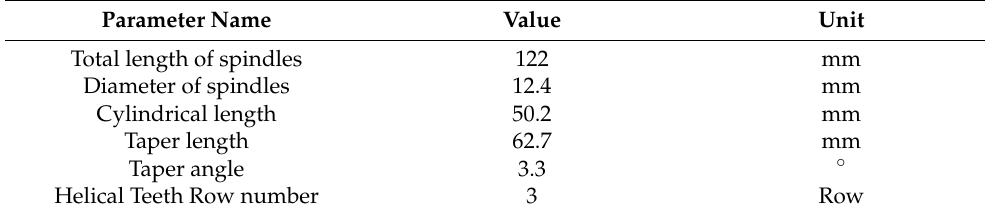
Table 1. Structure parameters of the